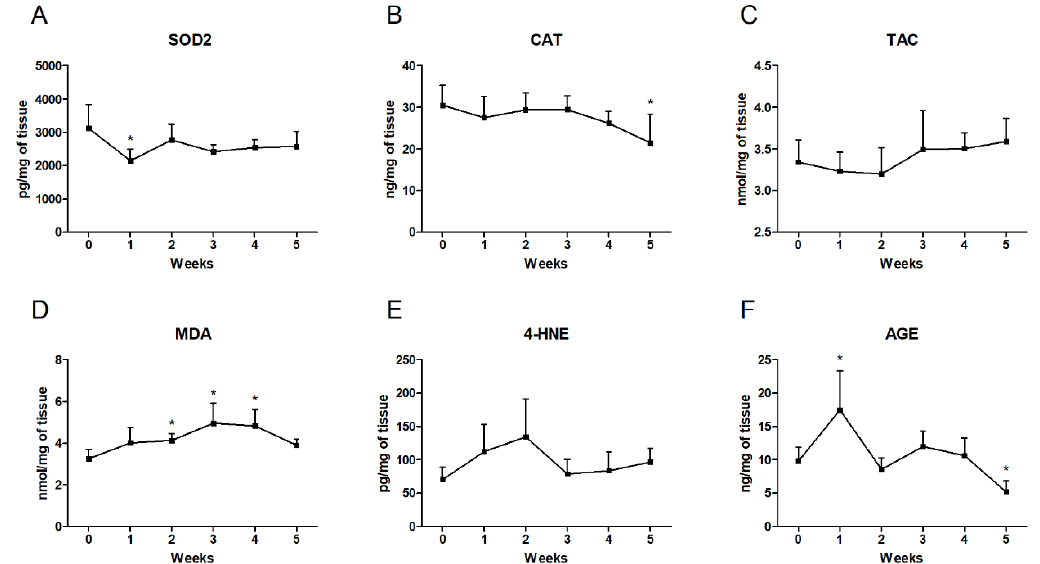
Figure 7. Modulation of the oxidant and antioxidant indicators, i.e., ( A ) superoxide dismutase 2 (SOD2), ( B ) catalase (CAT), ( C ) total antioxidant capacity (TAC), ( D ) malonyldialdehyde (MDA), ( E ) 4-hydroxynonenal (4-HNE) and ( F ) advanced glycation end-products (AGEs) in the liver homogenates. The indicator levels were determined using assay kits, as described in detail in the Materials and Methods section. The data are expressed as mean ± SD and are based on six independent determinations. * p < 0.05, significant difference compared with the control group (0 week).